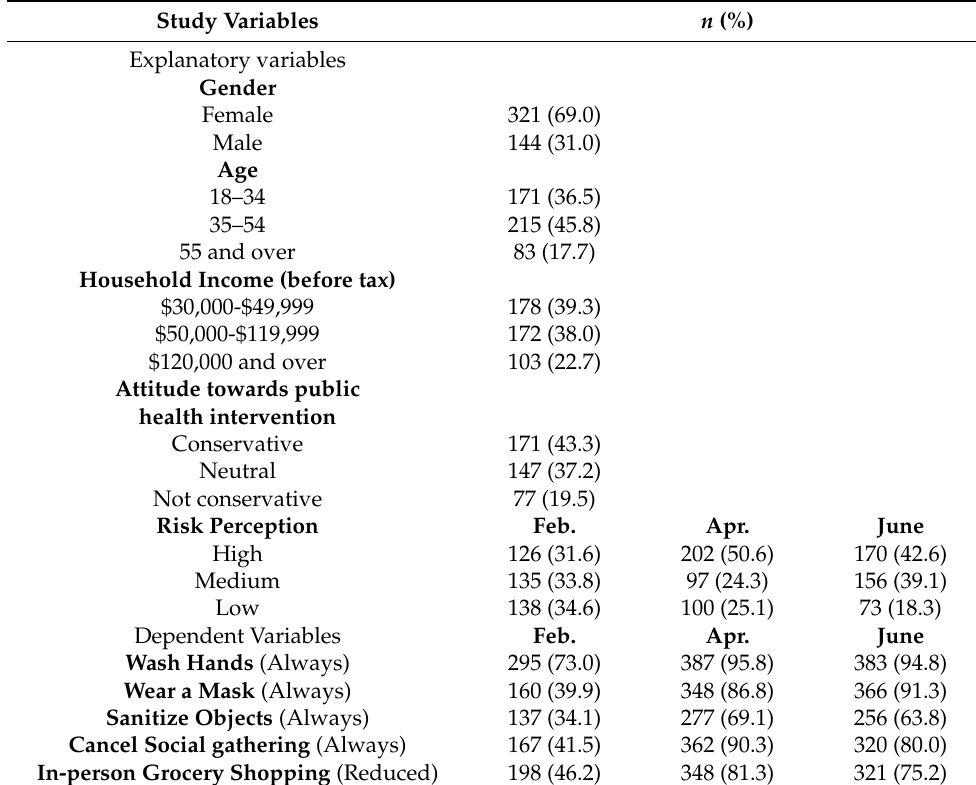
Table 1. Sample characteristics and study variables: count and valid percentage.